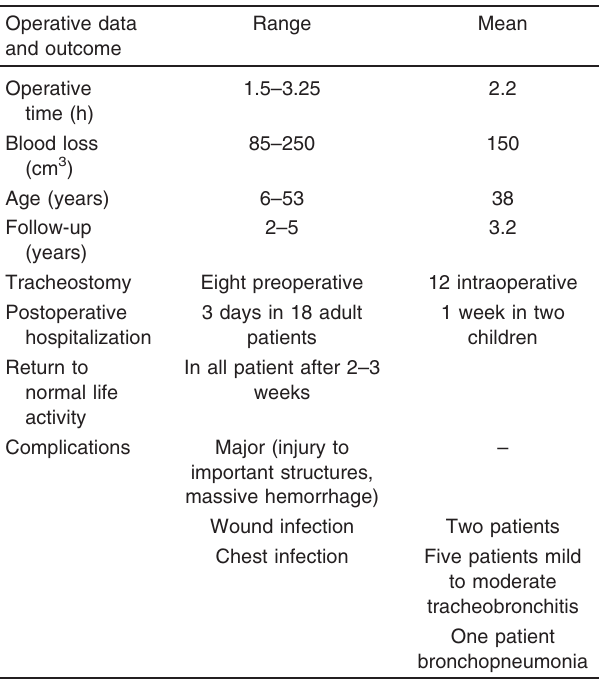
Table 2 Results and perioperative data Operative data and outcome